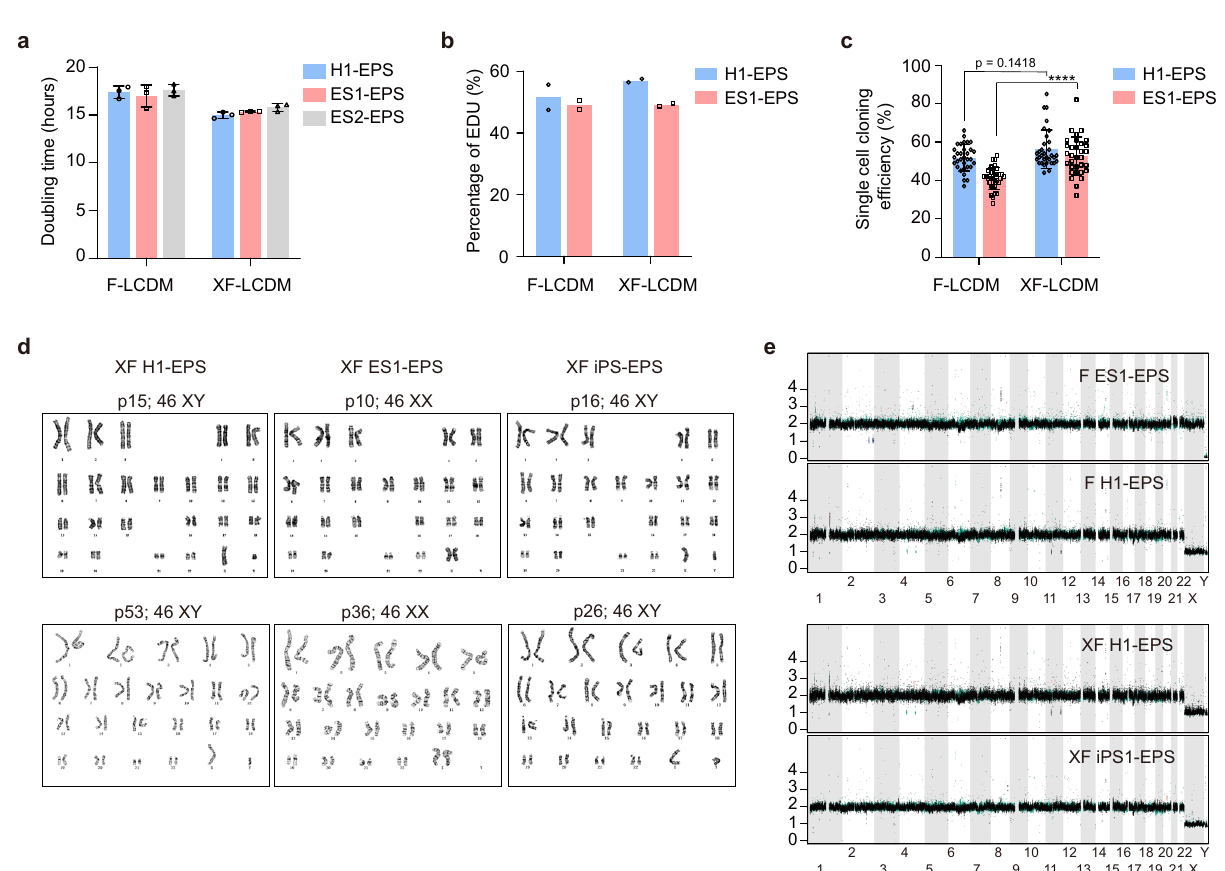
Fig. 2 Xeno-free human EPS cells proliferate well and maintain genome stability after long-term culturing. a Analysis of doubling time of feeder- cultured and xeno-free hEPS cells. n = 3 biologically independent samples. b FACS analysis of the percentages of EDU + cells in feeder-cultured and xeno- free hEPS cells. n = 2 biologically independent samples. c Single-cell cloning ef fi ciency of feeder-cultured and xeno-free hEPS cells. n = 32 biologically independent samples. d Karyotype analysis of xeno-free hEPS cells with different genetic backgrounds. e Chromosomal copy-number analysis of EPS cells by whole-genome sequencing. F-LCDM, hEPS cells cultured on feeders; XF-LCDM, xeno-free hEPS cells. Error bars, mean ± SD. All differences between means with P < 0.01 are indicated. ** P < 0.01; *** P < 0.001; **** P < 0.0001. Statistical signi fi cance was analyzed using one-way ANOVA with Tukey multiple comparison test ( a , c ). Experiments in a – c were all independently repeated at least three times with similar